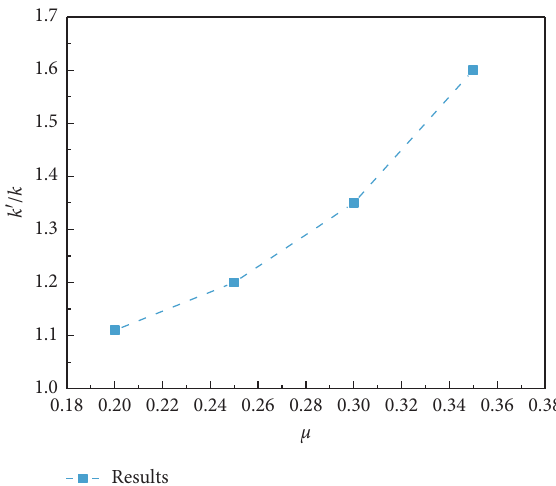
Figure 2: Values of k ′ / k for different Poisson